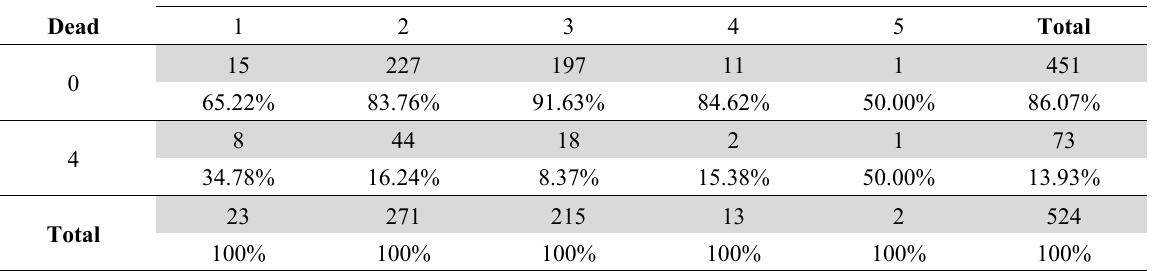
Dear quantities by accident type